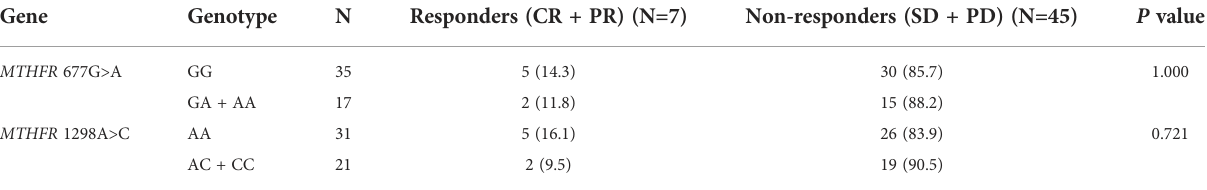
TABLE 4 Response rate of Thai colorectal cancer patients (N=52) in 5-FU based therapy. Gene